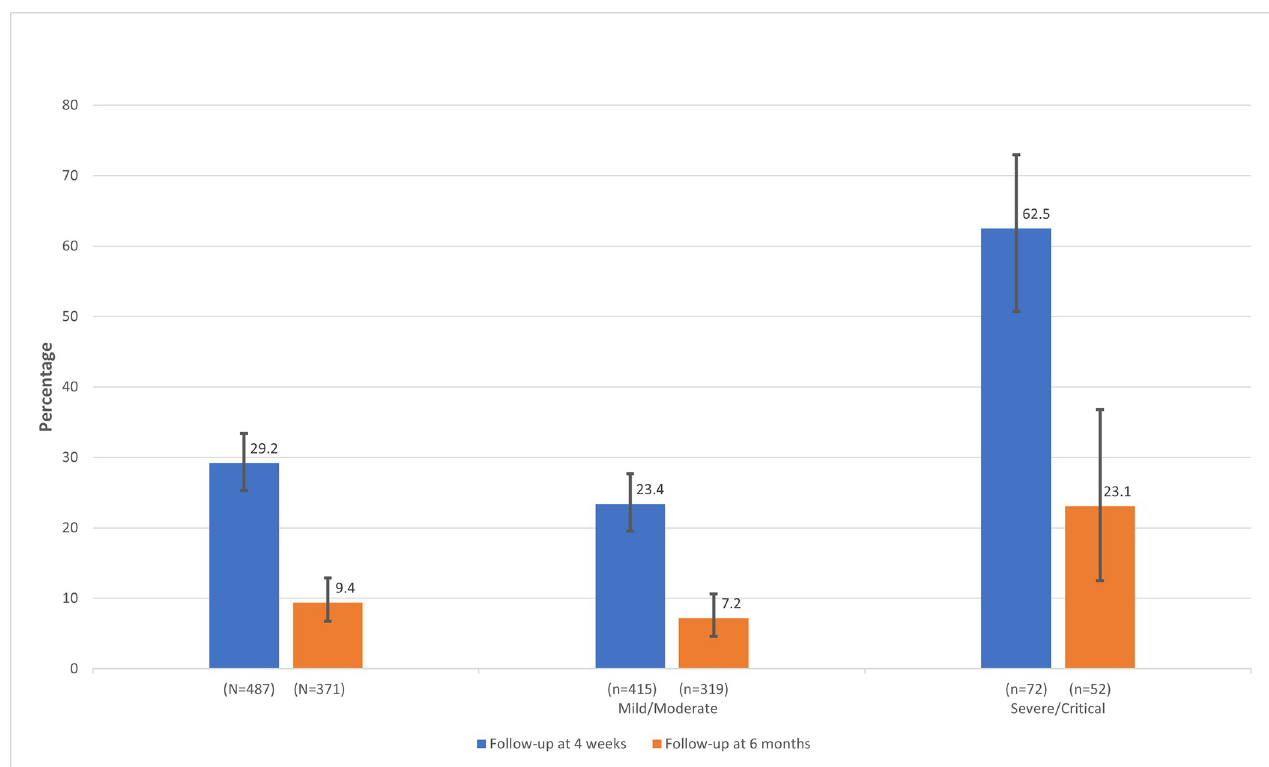
Fig 2. Percentage of self-reported Long COVID symptoms at four weeks and six months of follow-up.